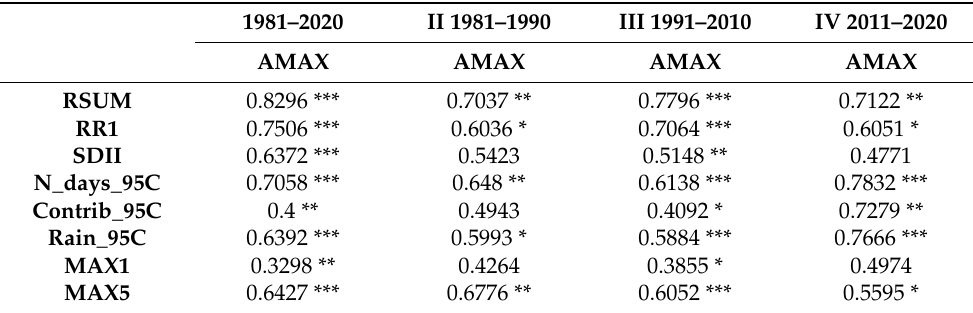
Table 12. Correlation matrix between red AMAX and rainfall indexes over MNRB. Pearson correlation